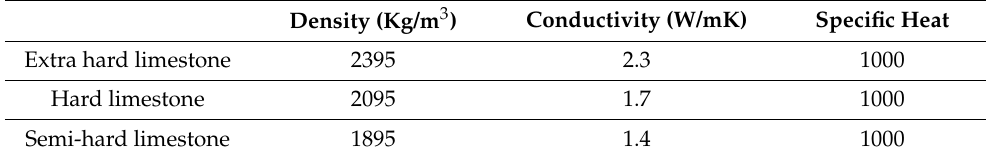
Table 2. Limestone characteristics.